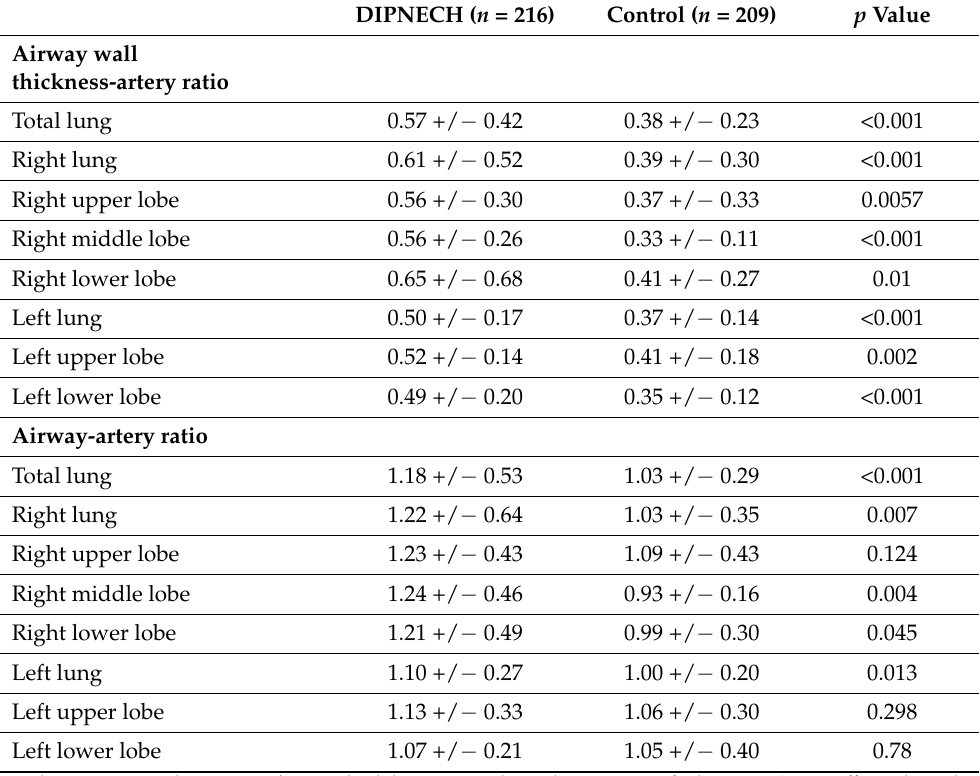
Table 1. Airway wall thickness artery & airway-arterial ratios.